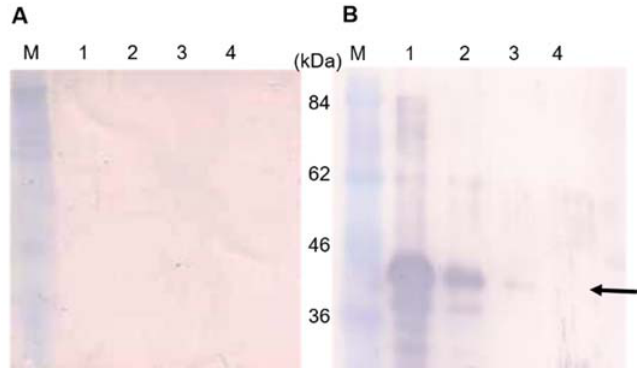
Figure 4. Western blot analysis of the recombinant SCMVCp protein. The purified recombinant proteins separated on SDS-PAGE and subjected to western blot analysis using pre-immune ( A ) and S5 serum ( B ). Lanes 1, 2, 3, and 4 are 1, 0.1, 0.01, and 0.001 µg of the purified protein, respectively. M is a protein marker.